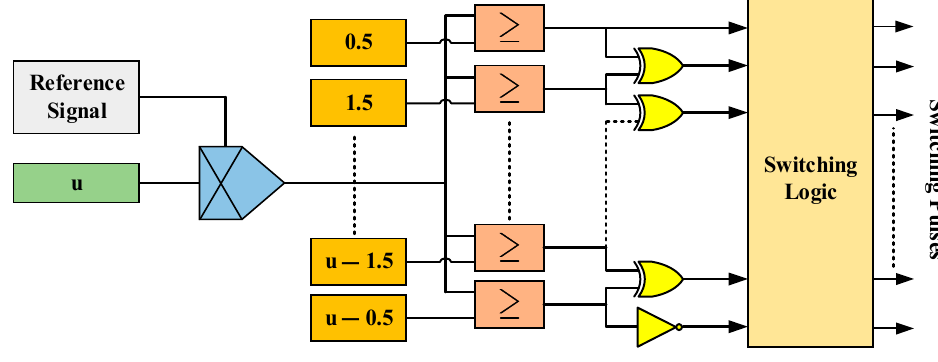
Figure 51. NLC working principle for switching pulse generation [92].